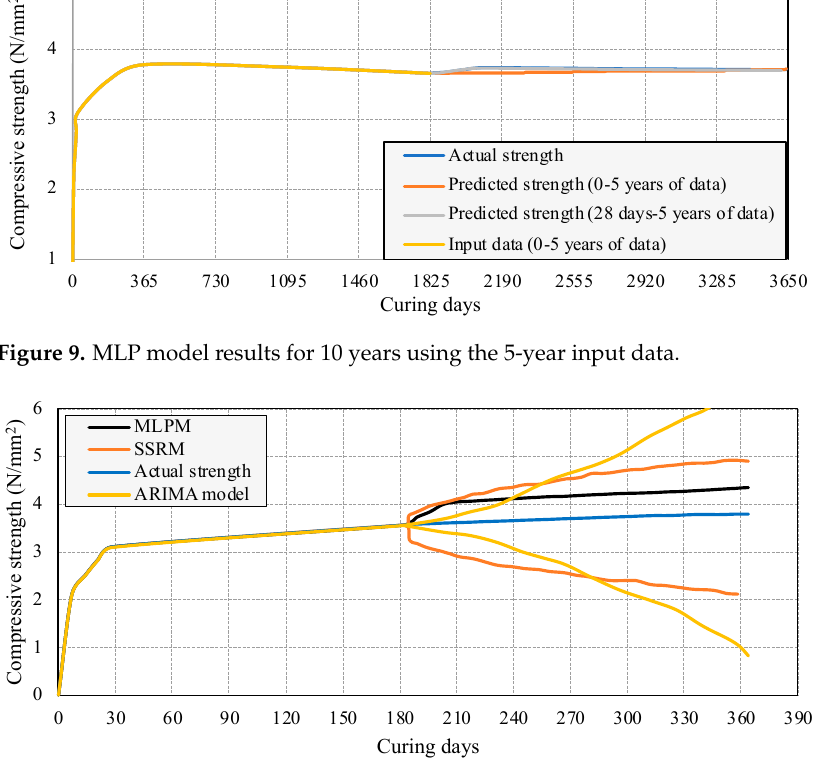
Figure 9. MLP model results for 10 years using the 5 ‐ year input data.